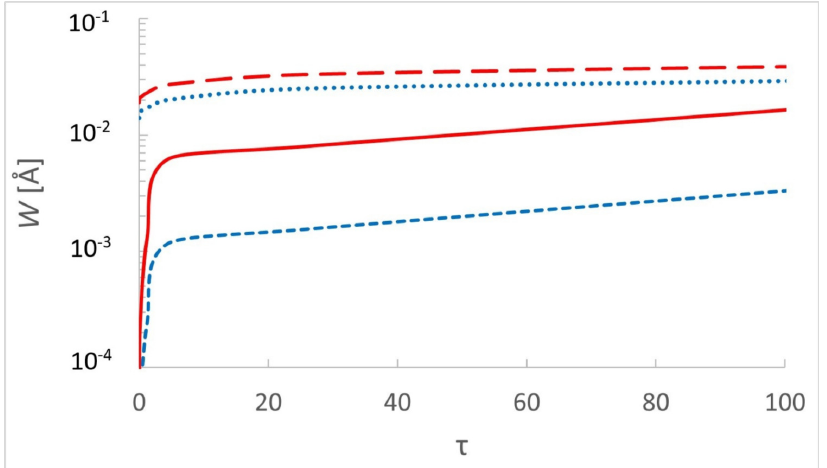
Figure 1. Dependence of Stark and Doppler full widths at half intensity maximum of Al IV 2s 2 2p 5 ( 2 P o )4s 2 [1/2] o − 2s 2 2p 5 ( 2 P o )4p 2 [3/2]0, λ = 4520.2 Å (red, Stark − solid line, Doppler − long 1/2 1/2 dashes) and 2s 2 2p 5 ( 2 P o )4p 2 [5/2] − 2s 2 2p 5 ( 2 P o )4d 2 [3/2] o , λ = 3411.8 Å (blue, Stark − dashes, 3/2 3/2